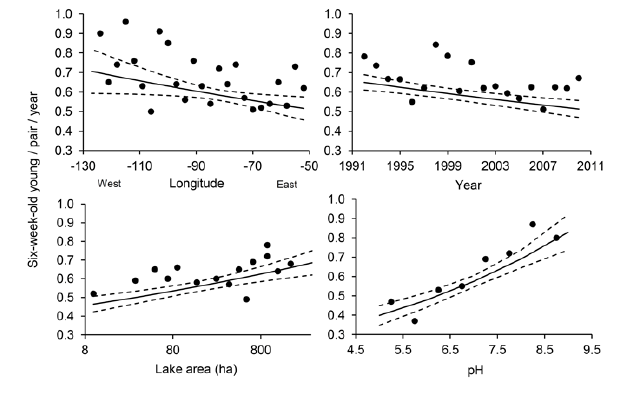
Fig. 3 . Reproductive success of Common Loons ( Gavia immer ) across southern Canada as a function of longitude, year, lake area, or pH between 1992 and 2010. Shown are model-averaged predictions from the best model that included the variable (solid lines, model; dashed lines, 95% confidence limits), with all other variables in the model held at median values. Longitude, year, and log lake area are based on models in part one of the analysis (Table 1), whereas pH is based on models in part two of the analysis (Table 3). Means are shown across each of several arbitrary bin classes (dots) to illustrate model fit, but be aware that these means were not the data used to fit the model. Note that lake area is shown on a log scale.